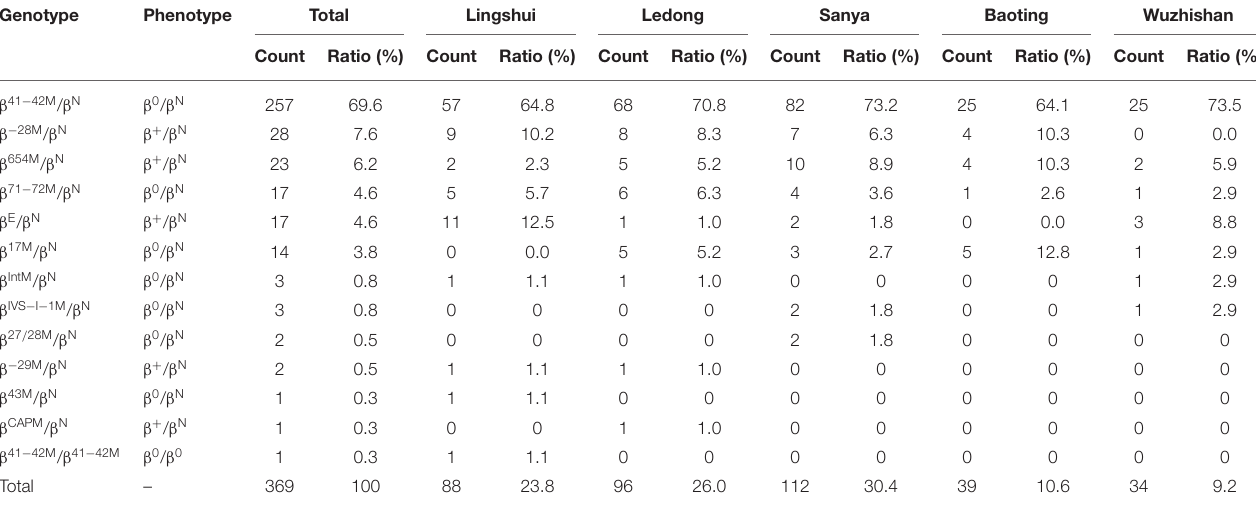
TABLE 2 | Distribution of β -thalassemia genotypes in the southern area of Hainan.